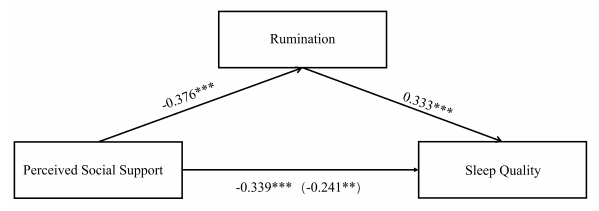
Fig. 1. The mediating role of rumination on sleep quality and perceived social support. *** p < 0.001.